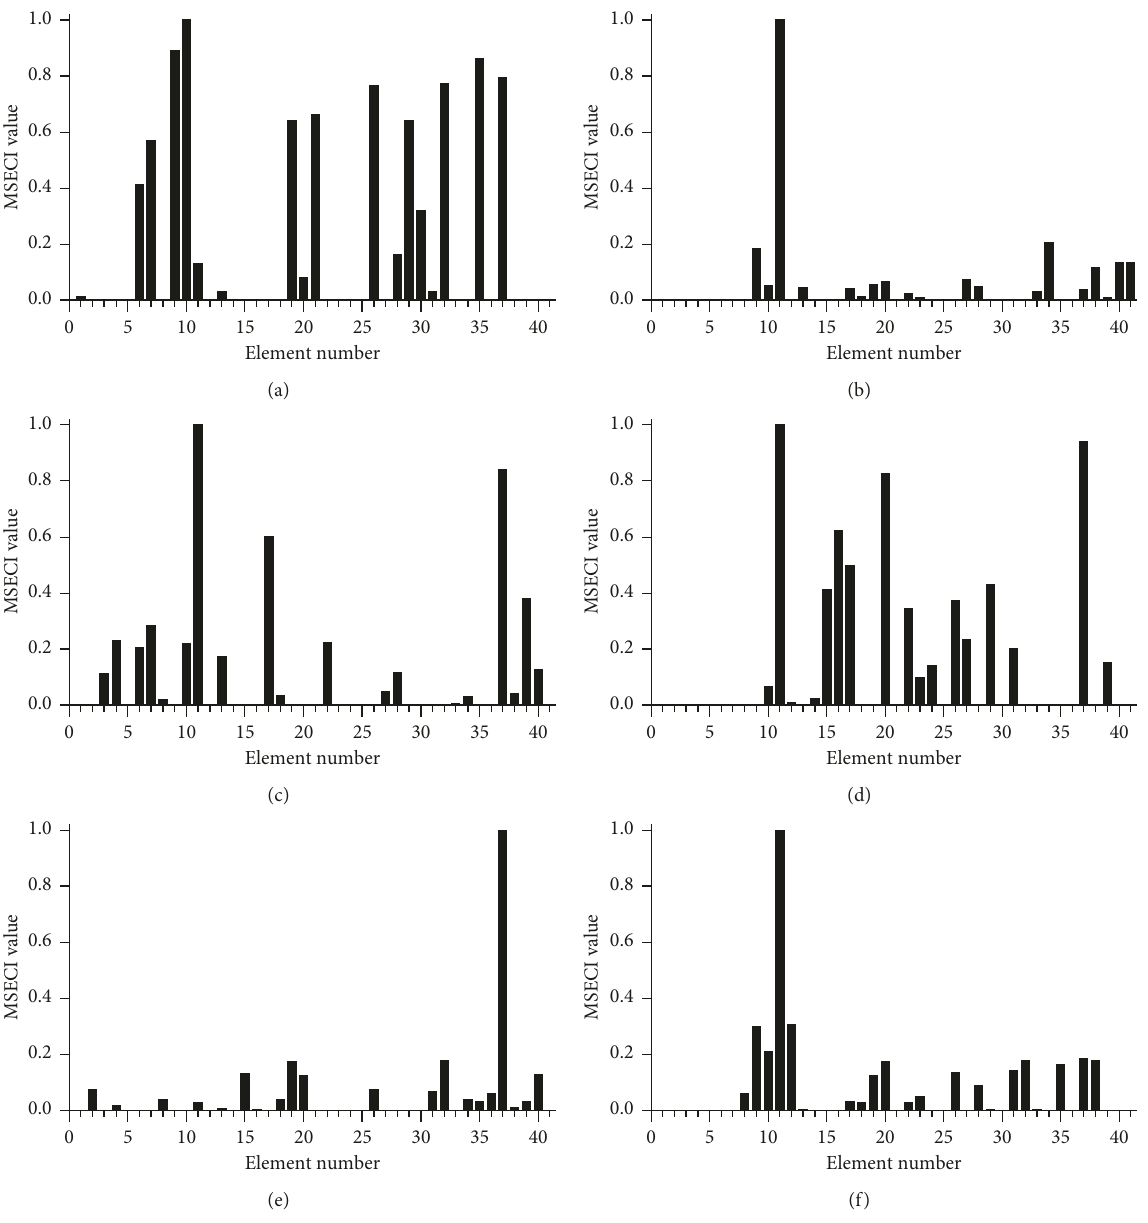
Figure 10: Values of the proposed MSECI using sensitive modes for in-turn checking (damaged element 11, 37, and 5% noise). (a) Checking element 8, using modes 8. (b) Checking element 11, using modes 7, 9, and 10. (c) Checking element 14, using modes 4, 5, and 7. (d) Checking element 19, using modes 4, 5, 9. (e) Checking element 37, using mode 2. (f) Checking element 38, using modes 7, 8, 9, and